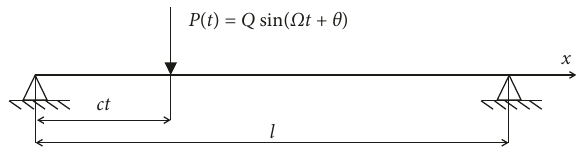
Figure 1: The simple rest beam model with moving